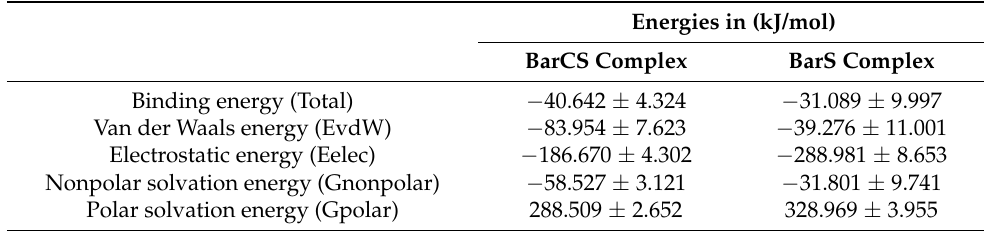
Table 4. Binding free energies ( ± standard deviations) from MM-PBSA calculations for BarCS complex and BarS